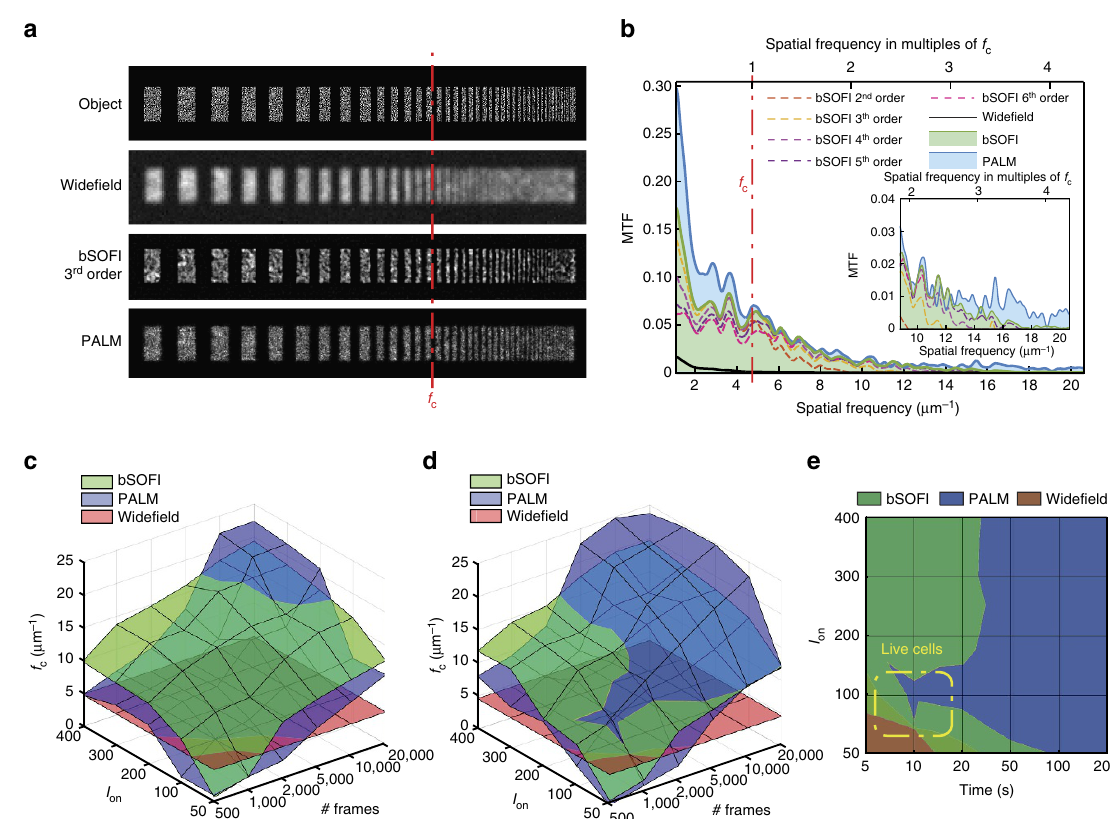
Figure 3 | MTF analysis on simulated PALM and SOFI images. ( a ) MTF test target consisting of single emitters randomly placed inside progressively thinner bars, together with resulting widefield, PALM and third order SOFI image ( I on ¼ 100 photons and 20,000 frames). The red line indicates the cutoff frequency f c for widefield imaging. The PALM images were rendered as localization number histograms (see Methods) with a pixel size equal to the SOFI pixel size. ( b ) MTF calculated from the simulated SOFI and PALM images in a . ( c , d ) Cutoff frequencies for PALM and SOFI as a function of I on and the number of frames, with an emitter density of ( c ) 1,200 m m (cid:2) 2 and ( d ) 800 m m (cid:2) 2 . ( e ) Two-dimensional projection of the chart in d . The timescale assumes a frame rate equal to 100Hz, which corresponds to the frame rate used for our live-cell measurements. Figure 3c,d shows the simulated cutoff frequency maps for PALM and SOFI based on the same test target, as a function of the number of frames and the number of photons per emitter per frame in an on-state (that is, I on ). Figure 3c corresponds to an emitter density of 1,200 m m (cid:2) 2 and the psCFP2 case, whereas Fig. 3d corresponds to 800 m m (cid:2) 2 and the mEos2 case. The number of frames ranges from 500 to 20,000. At 20,000 frames, all emitters are detected and the structure of the test pattern is